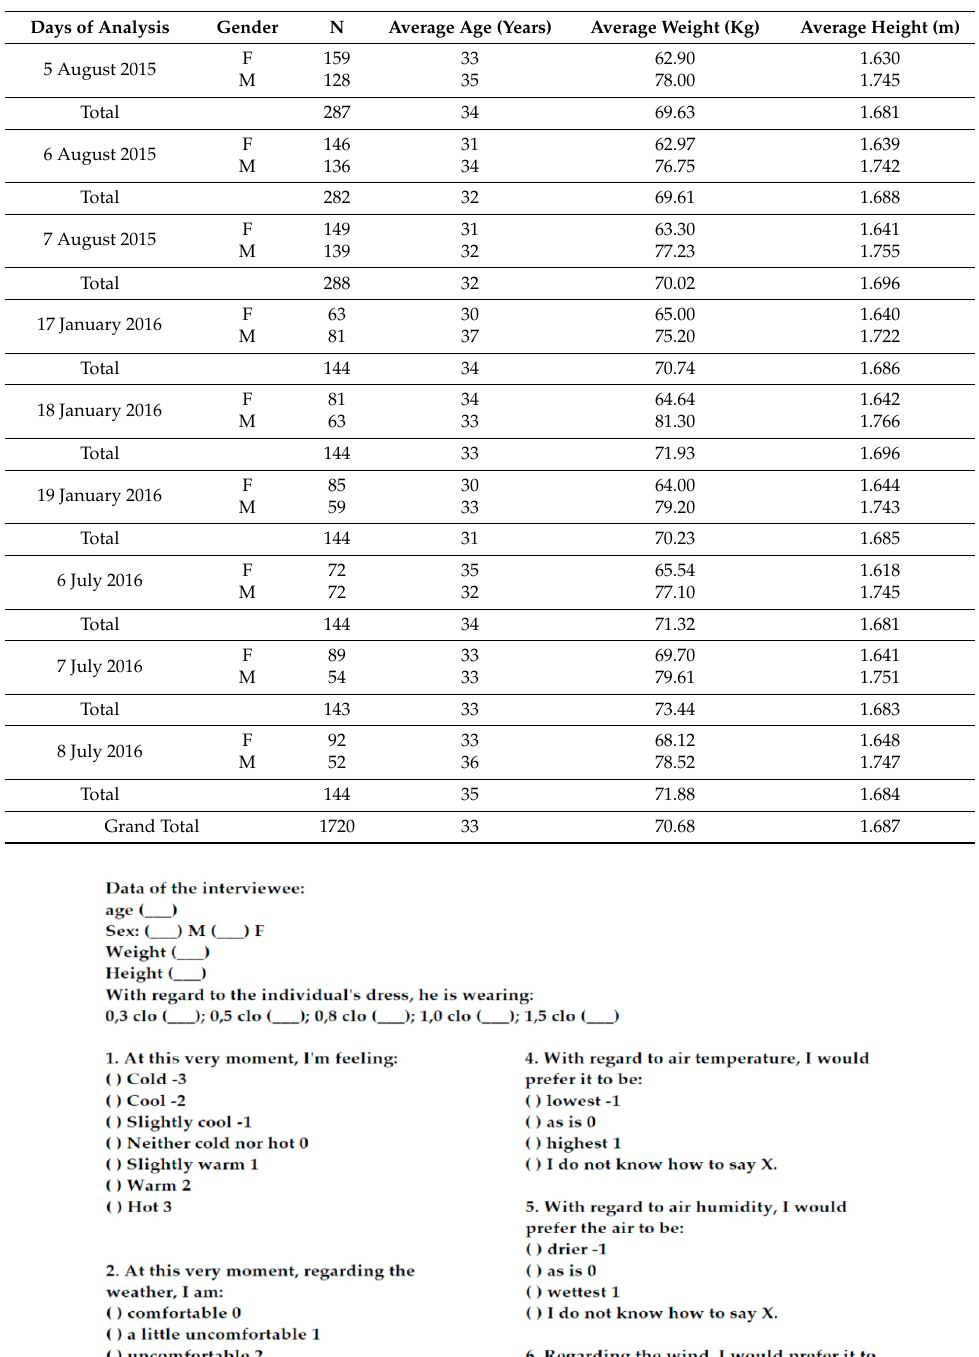
Table 3. Description of the analyzed population.